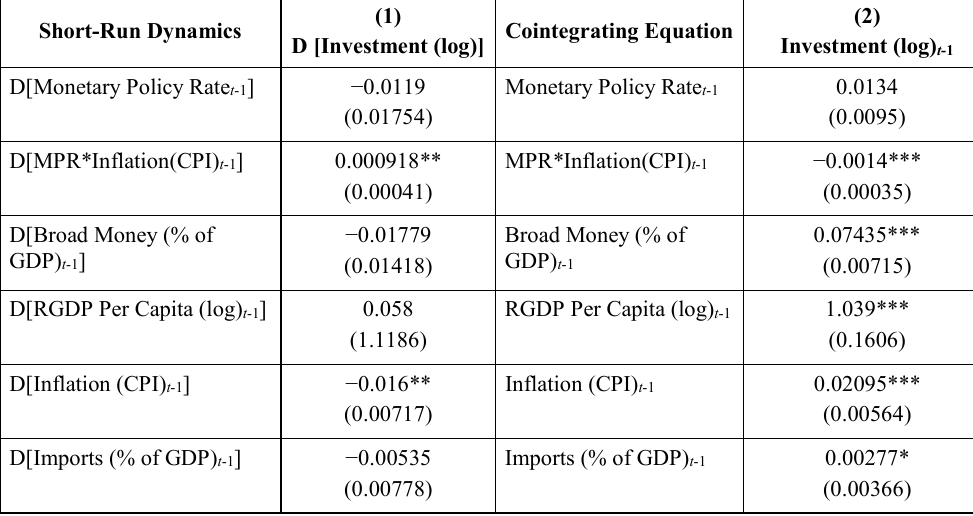
Table 7. Regression Result (with Interaction